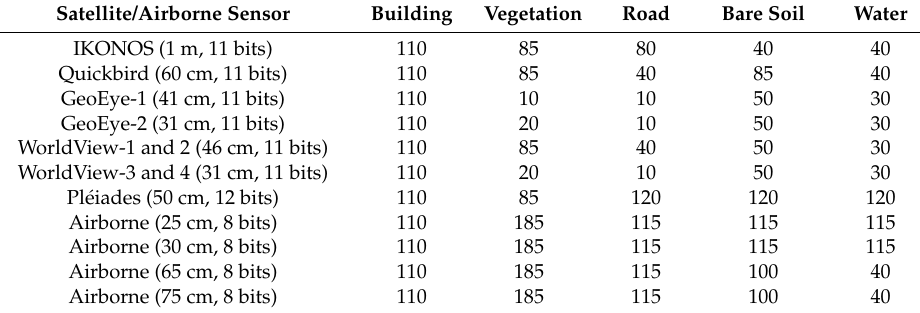
Table 5. SPs estimated by the RT models for common VHR satellite sensors and the airborne sensors applied in this study. Note: the SPs were derived from the RT models based on the shape and compactness criteria defined in Table 4. The SP values are valid for pansharpened images (where